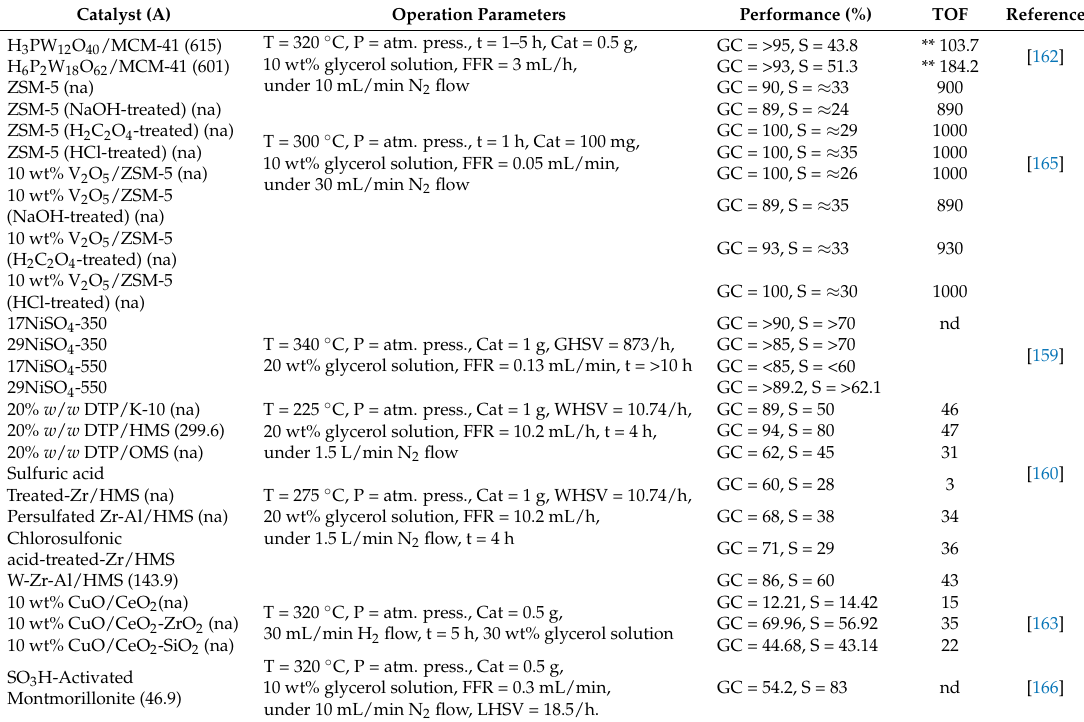
Table 11. Performance of some catalysts in the conversion of glycerol to acrolein as reported in some